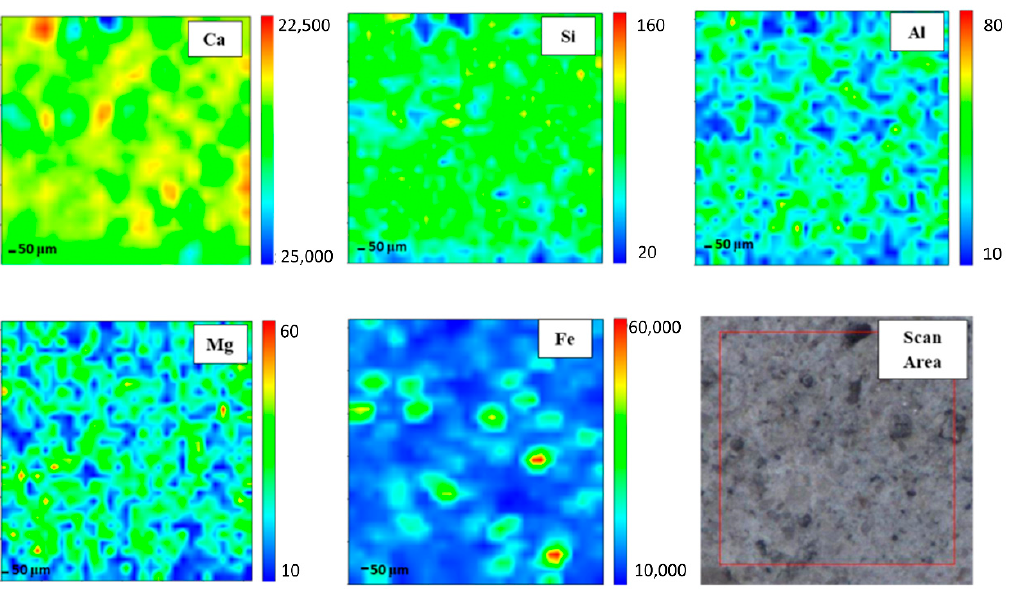
Figure 2. Micro-XRF elemental mapping of Ca, Si, Al, Mg and Fe in a ~961 × 50 µ m overview of dolomite / fly ash geopolymer composites unexposed at elevated temperature.